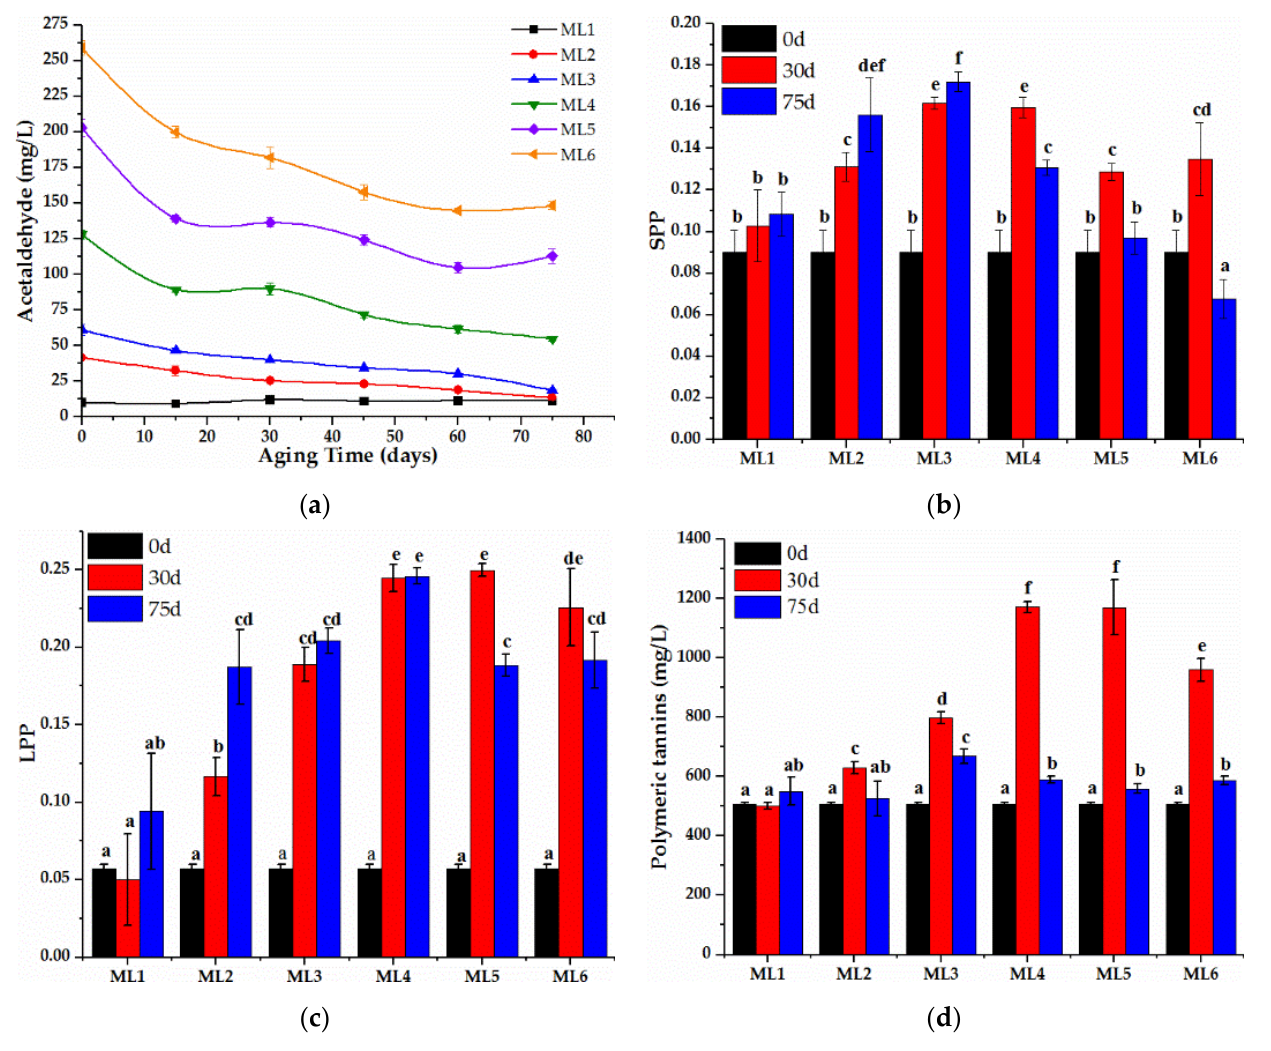
Figure 2. Evolution of acetaldehyde ( a ), SPP ( b ), LPP ( c ) and PT ( d ) during wine aging of 75 days. Different letters indicate significant differences at the 0.05 level. Abbreviations: ML1, wines containing 7.86 ± 0.10 mg/L acetaldehyde; ML2, wines containing 41.72 ± 1.97 mg/L acetaldehyde; ML3, wines containing 61.19 ± 3.93 mg/L acetaldehyde; ML4, wines containing 128.10 ± 3.08 mg/L acetaldehyde; ML5, wines containing 203.02 ± 6.00 mg/L acetaldehyde; ML6, wines containing 259.02 ± 4.95 mg/L acetaldehyde; SPP, short polymeric pigments; LPP, large Polymeric Pigments; PT, polymeric tannins.